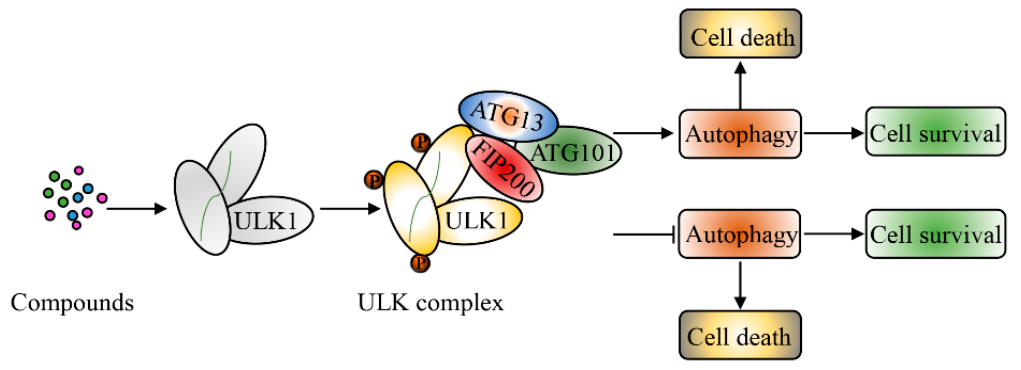
Figure 2. Summary of the relationships between ULK1, autophagy, and cancer.